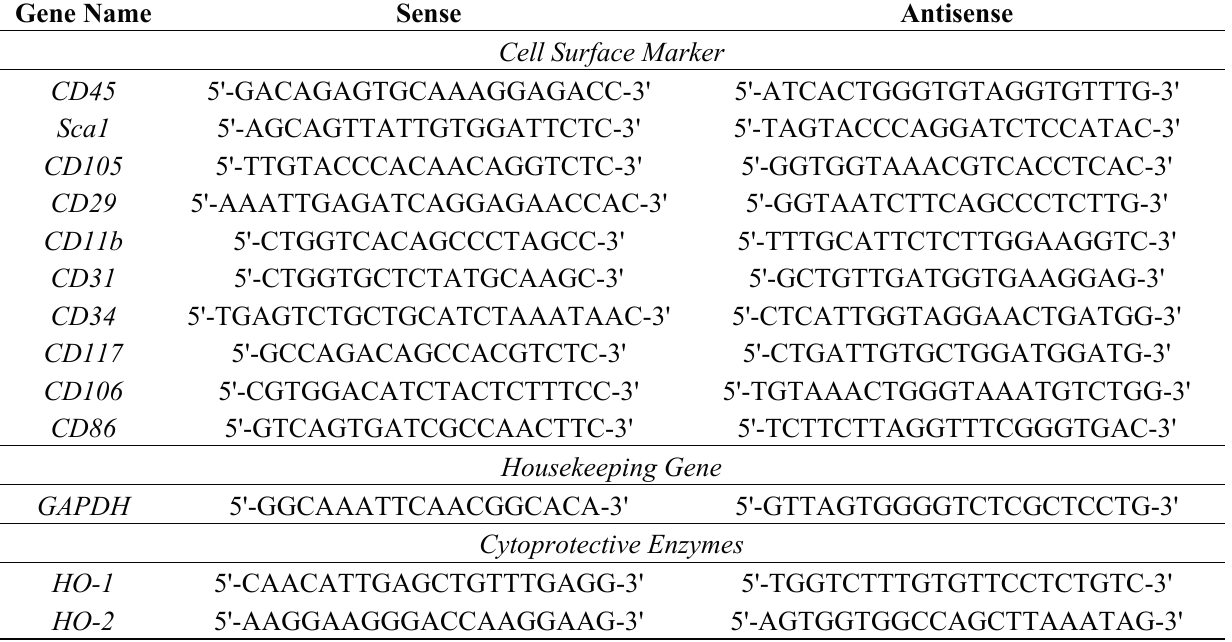
Table 1. Primer sequences of mouse ASC cell surface markers and cytoprotective